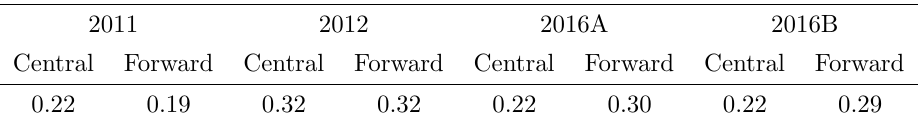
Table 4 . Analysis BDT discriminator minimum requirements per channel and running period for the 1D and 2D e(cid:11)ective lifetime